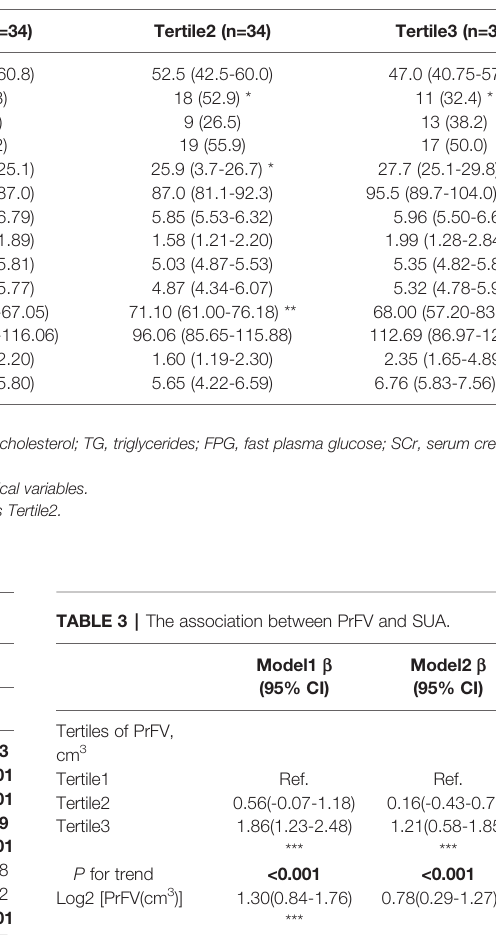
TABLE 1 | Characteristics of the study population strati fi ed across PrFV